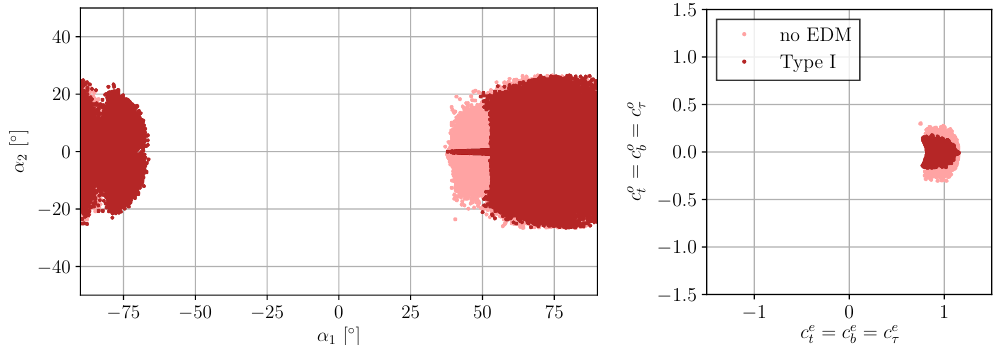
Figure 1 . C2HDM Type I: for sample 1 (dark) and sample 2 (light) left: mixing angles (cid:11) the C2HDM mixing matrix R only including scenarios where H